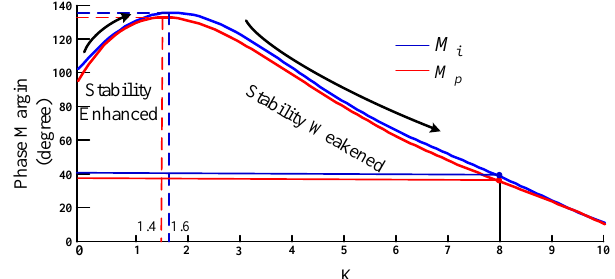
Figure 6. Phase margin of VSC when the proposed controller with different K .